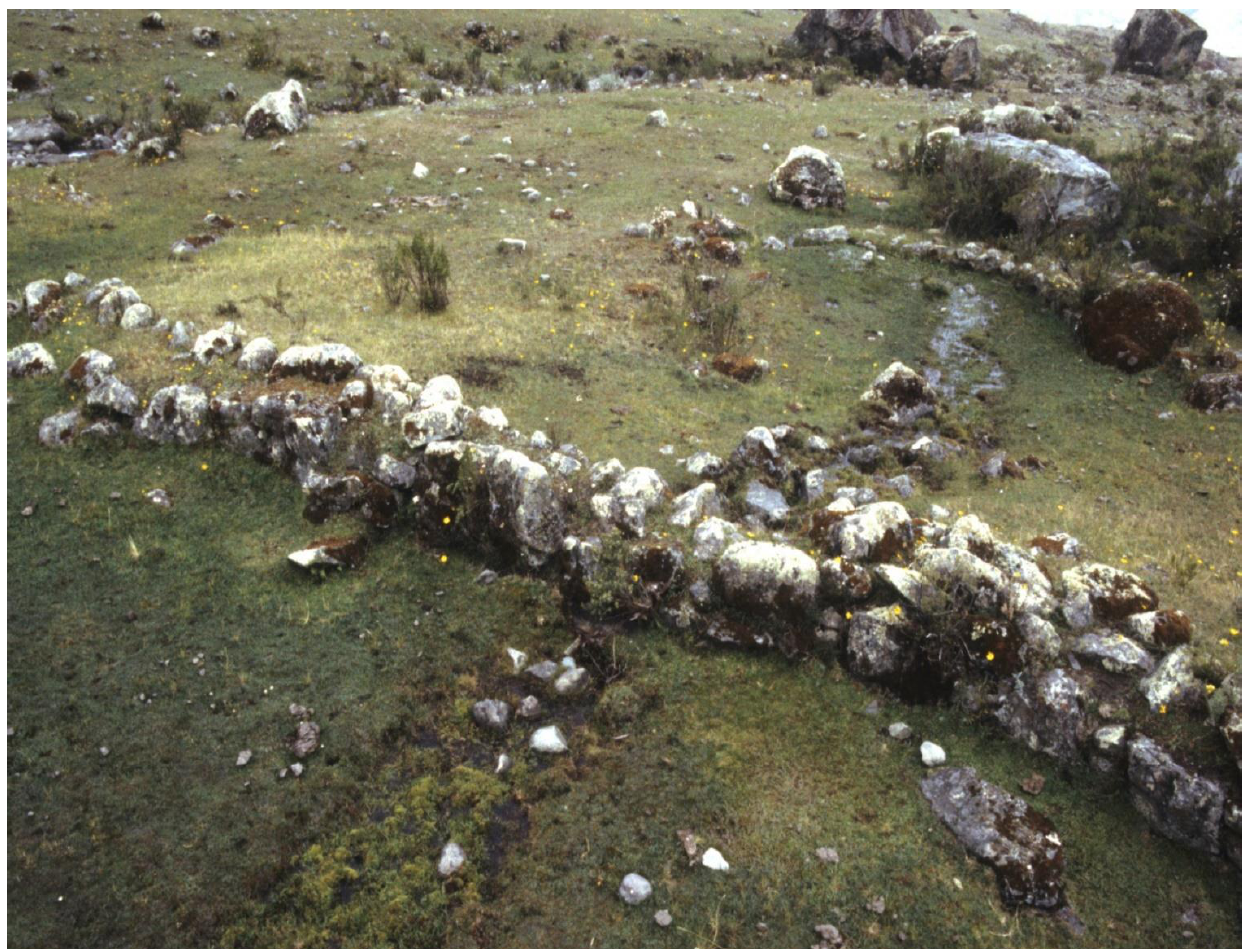
Figure 11. Two silt reservoirs from Putacayoc-Kaukayoc [Cho